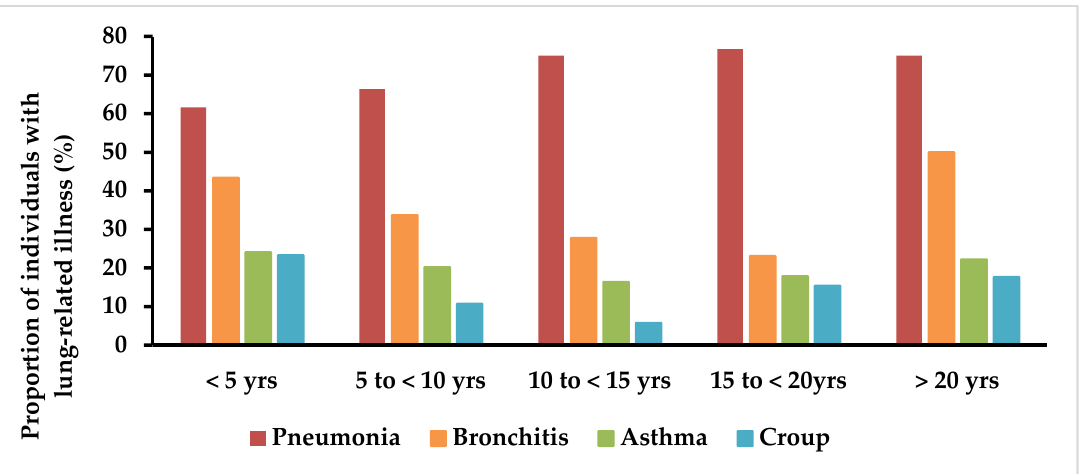
Figure 2. Frequency distribution of pneumonia, bronchitis, asthma and croup being sometimes or constantly a problem during 5 year epochs. Note: Sample size decreases with each increasing 5 year epoch.